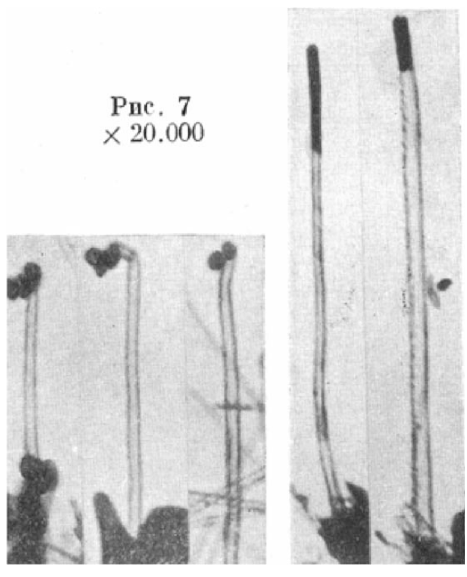
Figure A2. The earliest TEM images of carbon nanotubes published in Reference